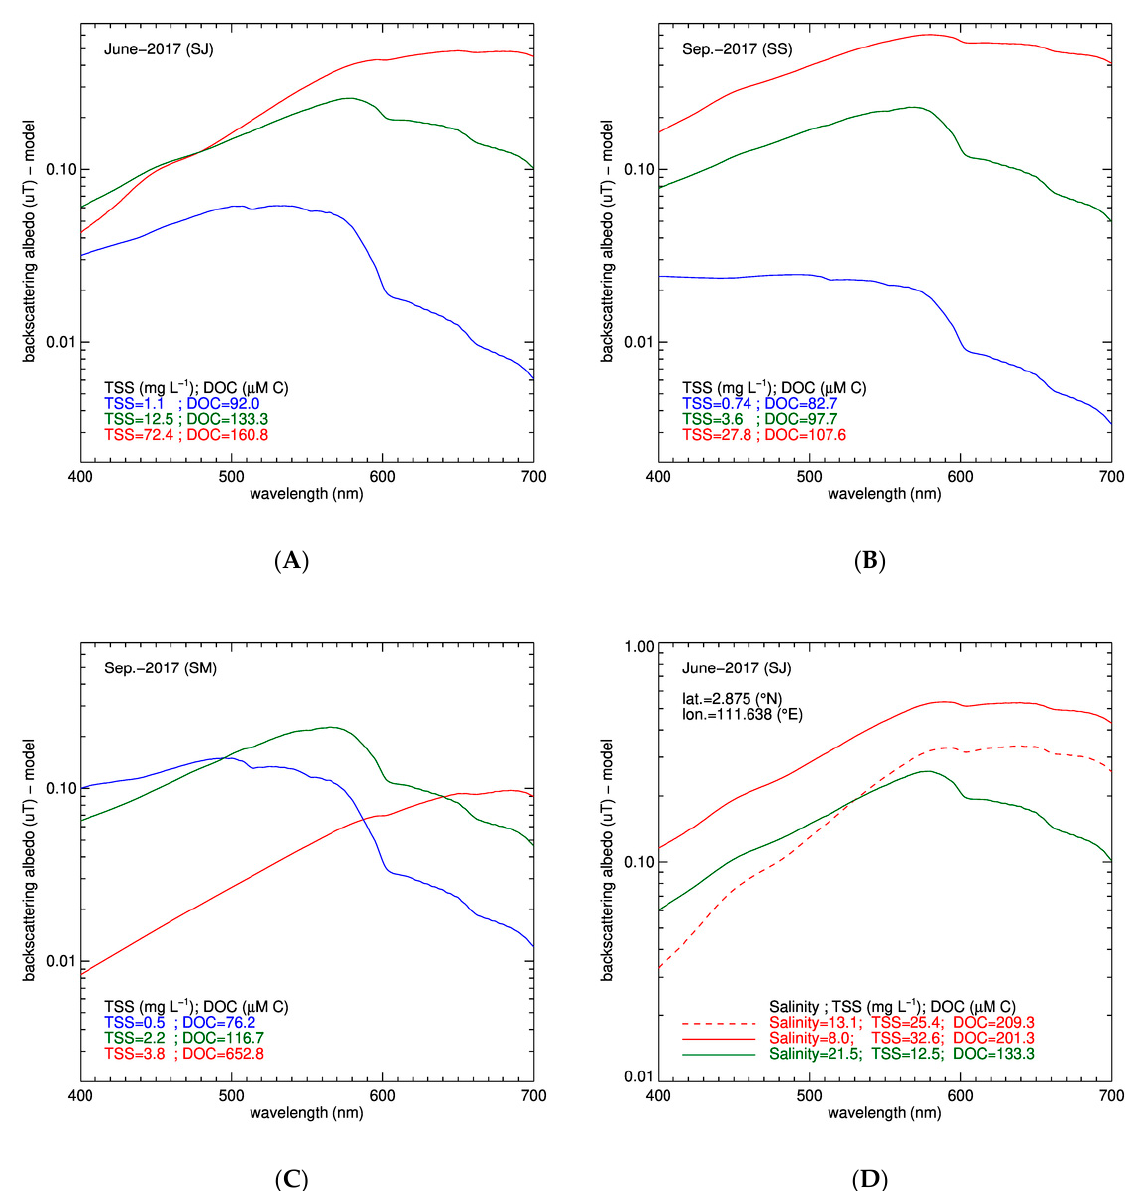
Figure 5. Variability of backscattering albedo in Sarawak coastal waters. ( A ) spectral variability during June 2017 along the eastern coast of Sarawak, ( B ) spectral variability during September 2017 along the eastern coast of Sarawak, ( C ) spectral variability during September 2017 along western coast of Sarawak (off Samunsam and Sematan river mouths) and ( D ) changes in spectral shape of backscattering albedo under the influence of river discharges along the eastern coast of Sarawak during June 2017.